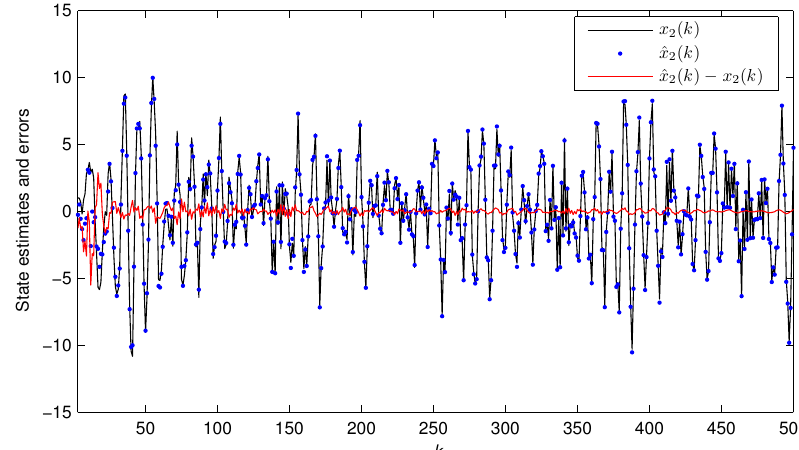
Figure 10. The true state x 2 ( k ) and the estimated state ˆ x 2 ( k ) versus k for Example 2 ( δ = 0.25).